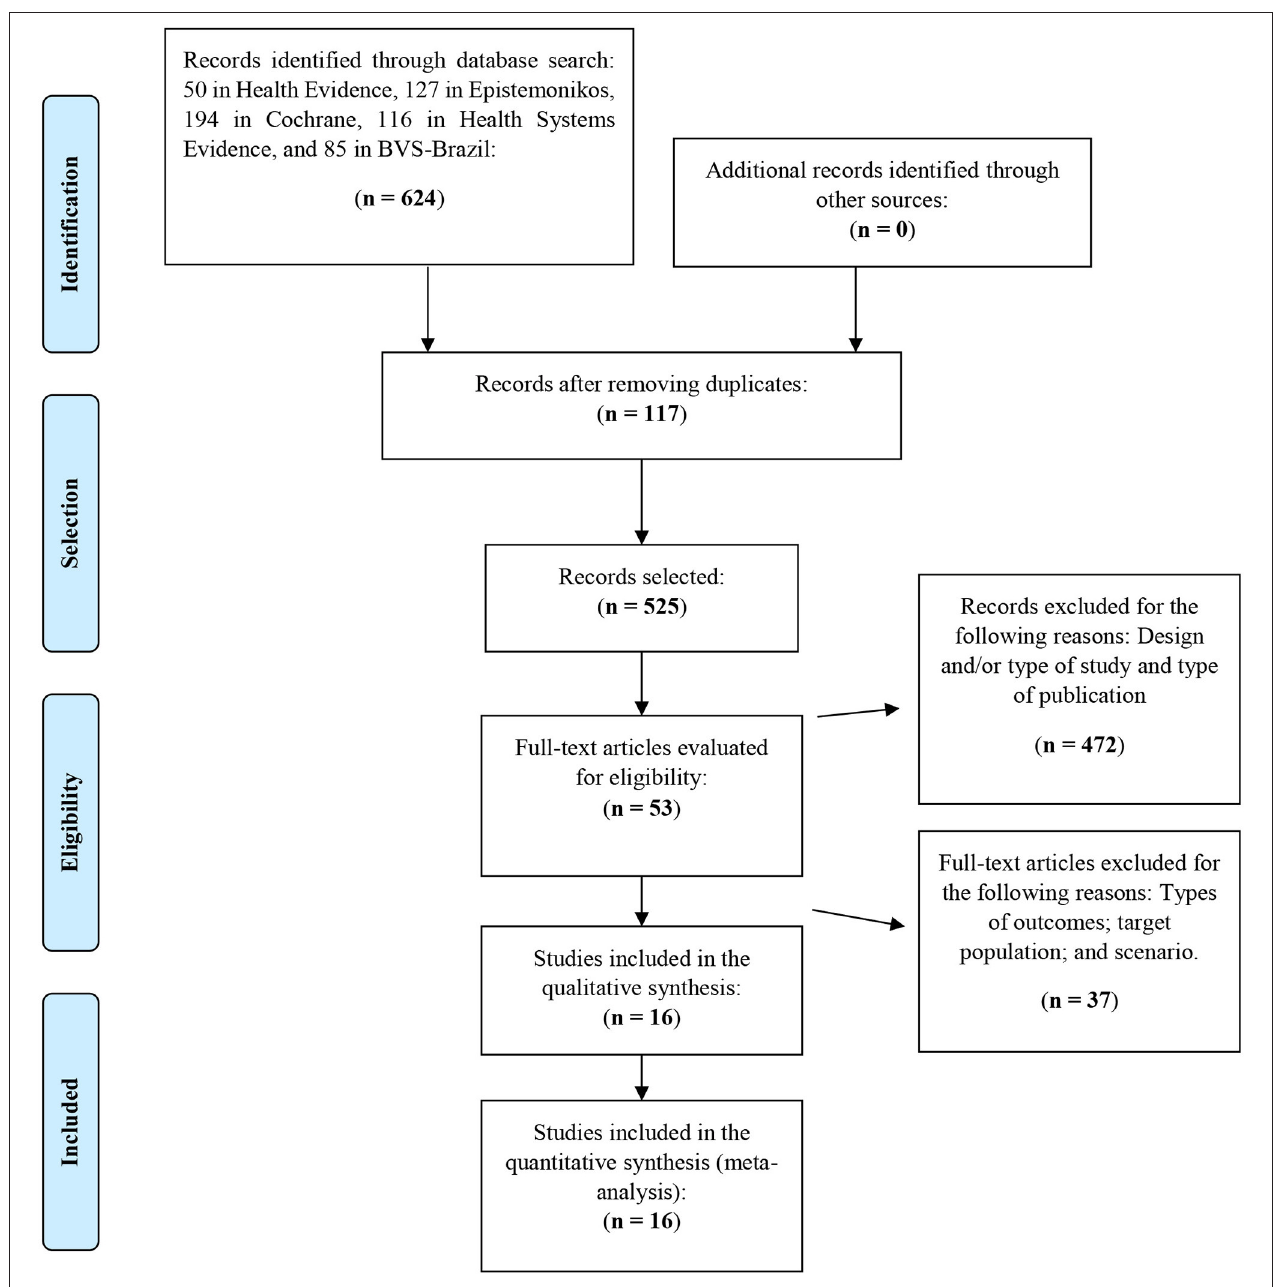
FIGURE 1 | Flowchart of the selection process of the articles included in the review. Adapted from Moher et al. (2009). Complementary information: www.prisma-statement.org.